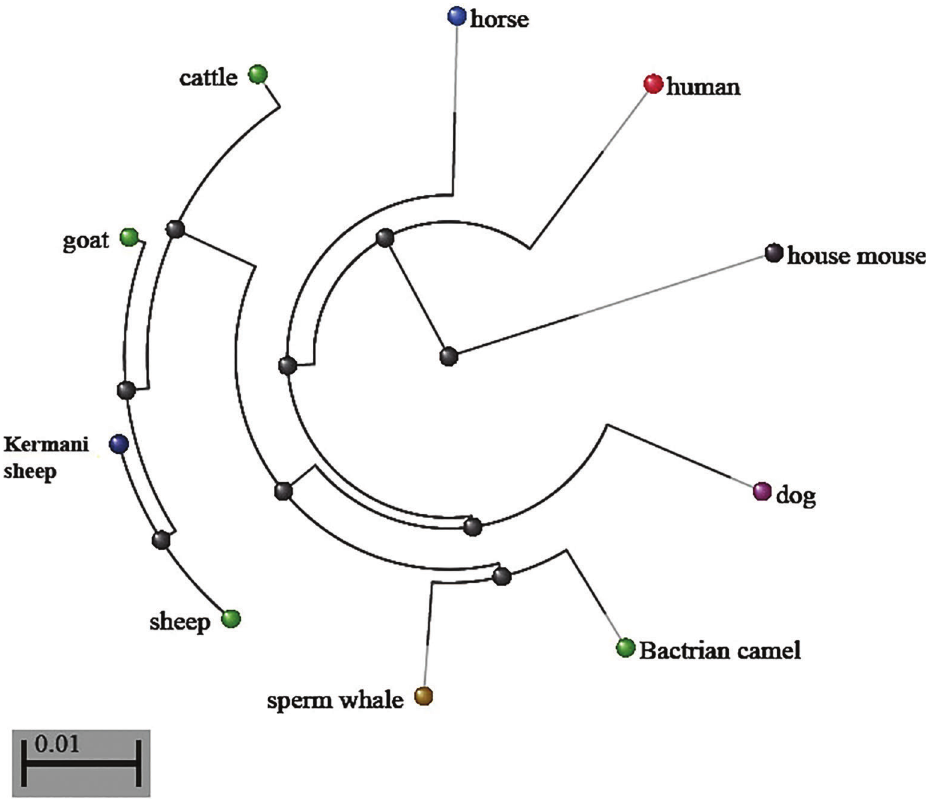
Figure 4. Phylogenetic tree for several CIB 4 genes in 9 species. The sheep CIB 4 gene nucleotide sequence was aligned with other homologous CIB 4 genes. The plylogenetic tree was constructed by neighbor-joining method using MEGA4.1 software. The